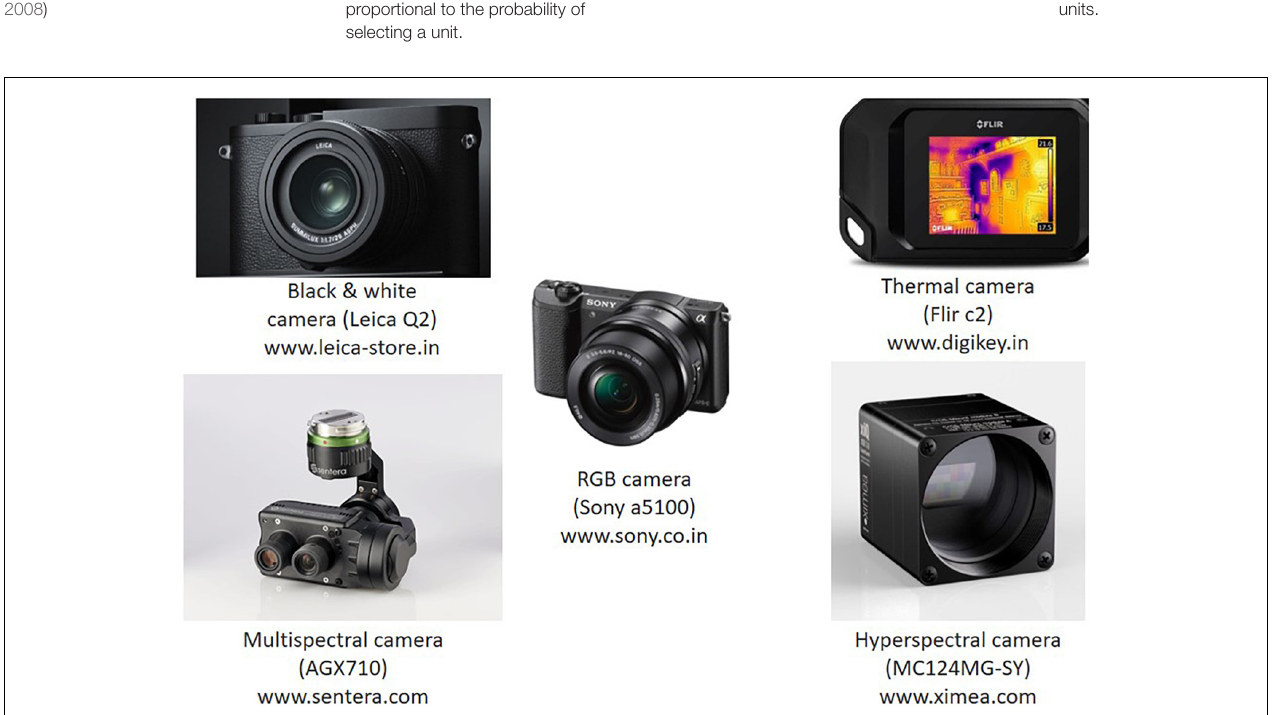
FIGURE 3 | Different types of camera models using various sensor technologies.